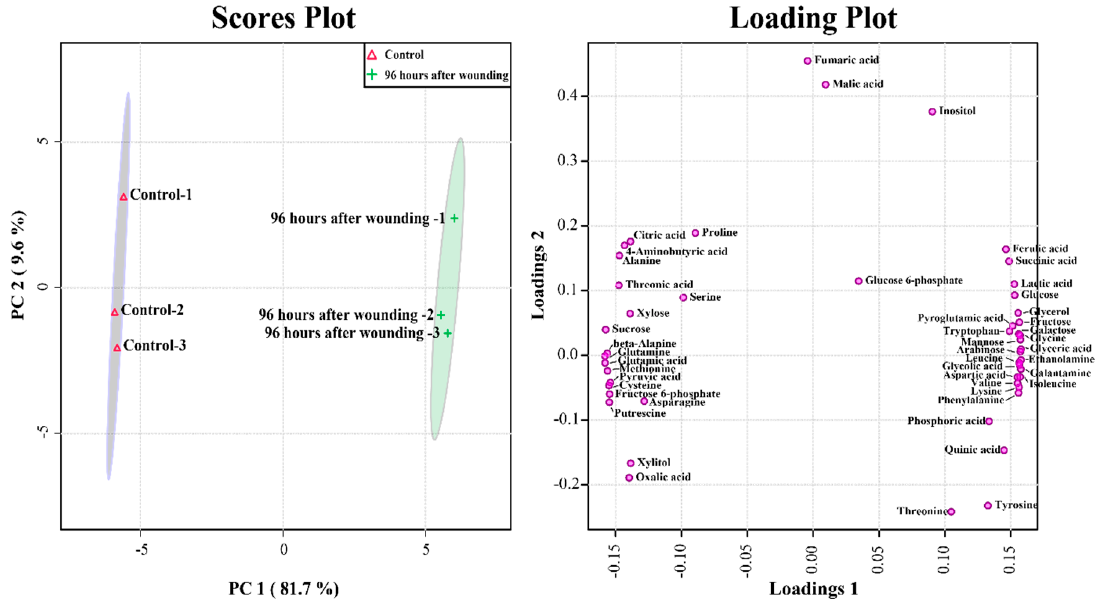
Figure 4. Score plots and metabolite differences between calli exposed for 0 and 96 h derived from a PCA model of GC-TOFMS results.